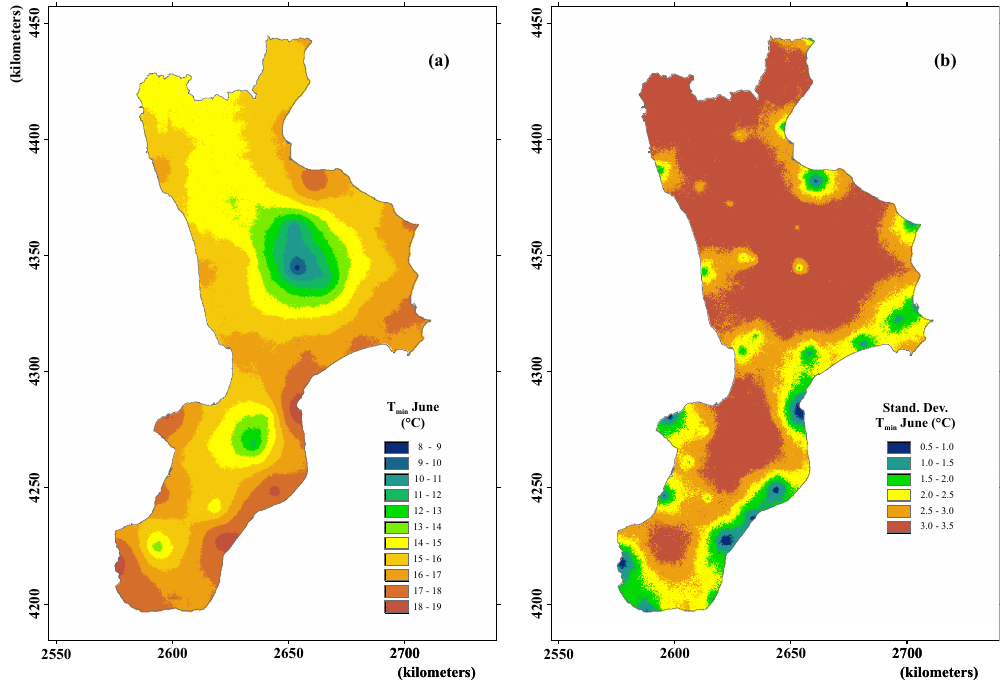
Fig. 2. Mean (a) and standard deviation (b) maps of simulations for the mean minimum temperature ( T min ).